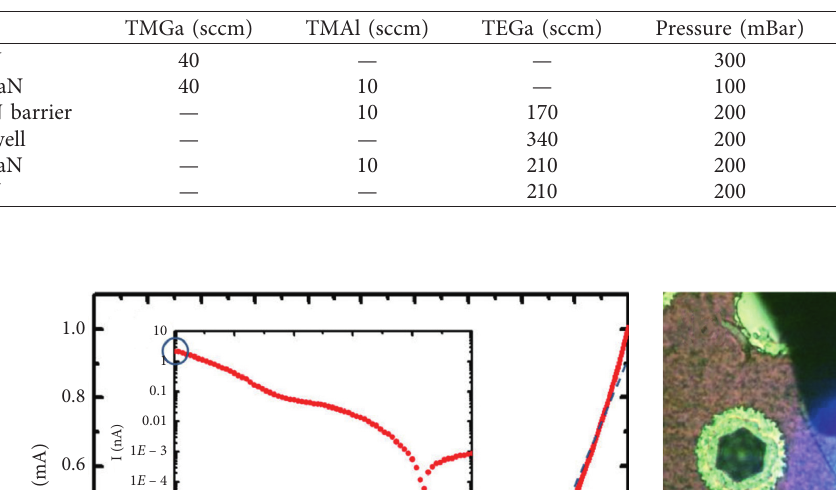
Table 1: The growth condition of the micropyramid LED in window areas.